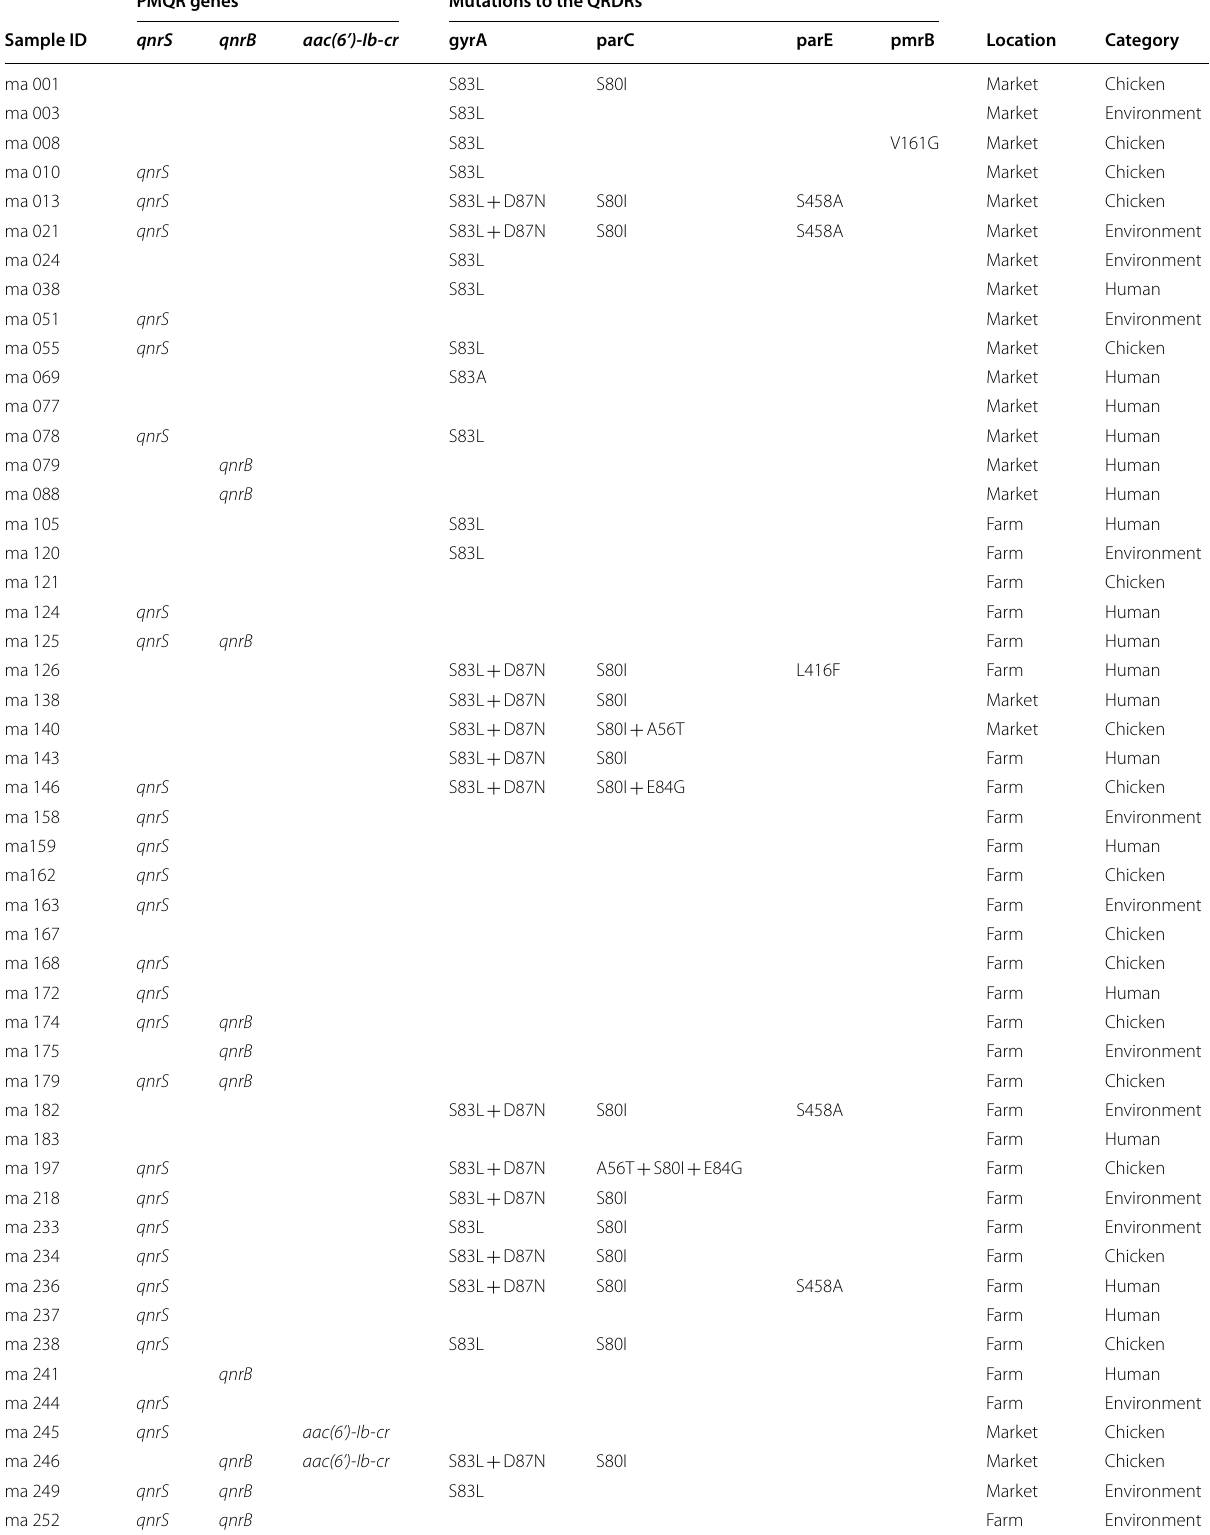
Table 4 Distribution of PMQR genes and QRDR mutations among 75 NAlidixic acid resistant Escherichia coli isolates PMQR genes Mutations to the